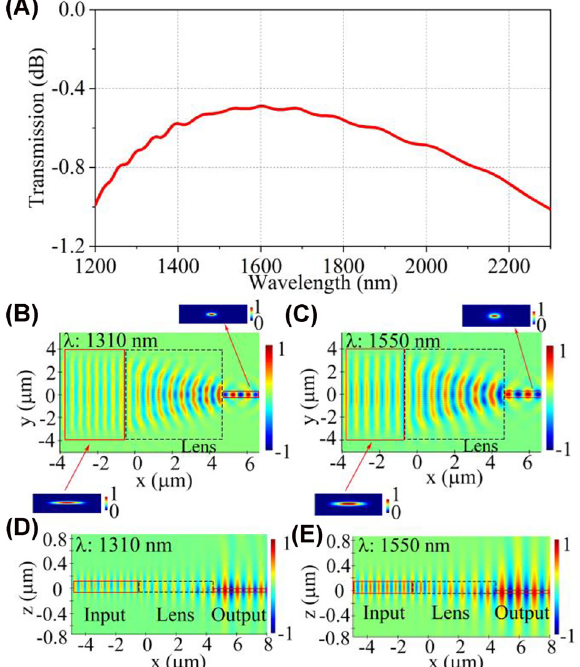
Figure 4: Simulated performance of the on-chip GRIN metalens for matching two modes with different modal sizes. (A) Transmission spectrum of the on-chip GRIN metalens. Xy -plane electrical field ) of the lens at (B) 1310 nm and (C) 1550 nm. Xz -plane distribution ( E y ) of the lens at (D) 1310 nm and (E) electrical field distribution ( E y 1550 nm. Insets display the yz -plane TE mode fields in the input and 0 output silicon